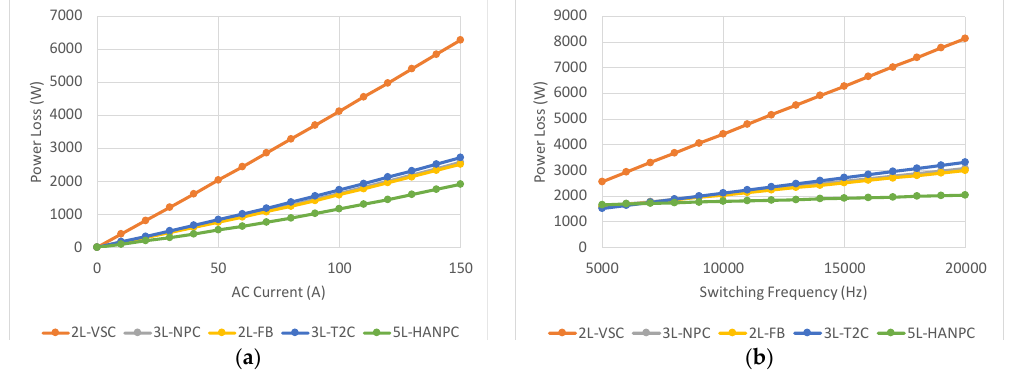
Figure 5. Loss performance comparison in the inverter mode (power factor = −1, M = 0.47) under different conditions: ( a ) varied AC currents and a fixed switching frequency ( f s = 15 kHz); and ( b ) varied switching frequencies and a fixed AC current ( I ac = 100 A).